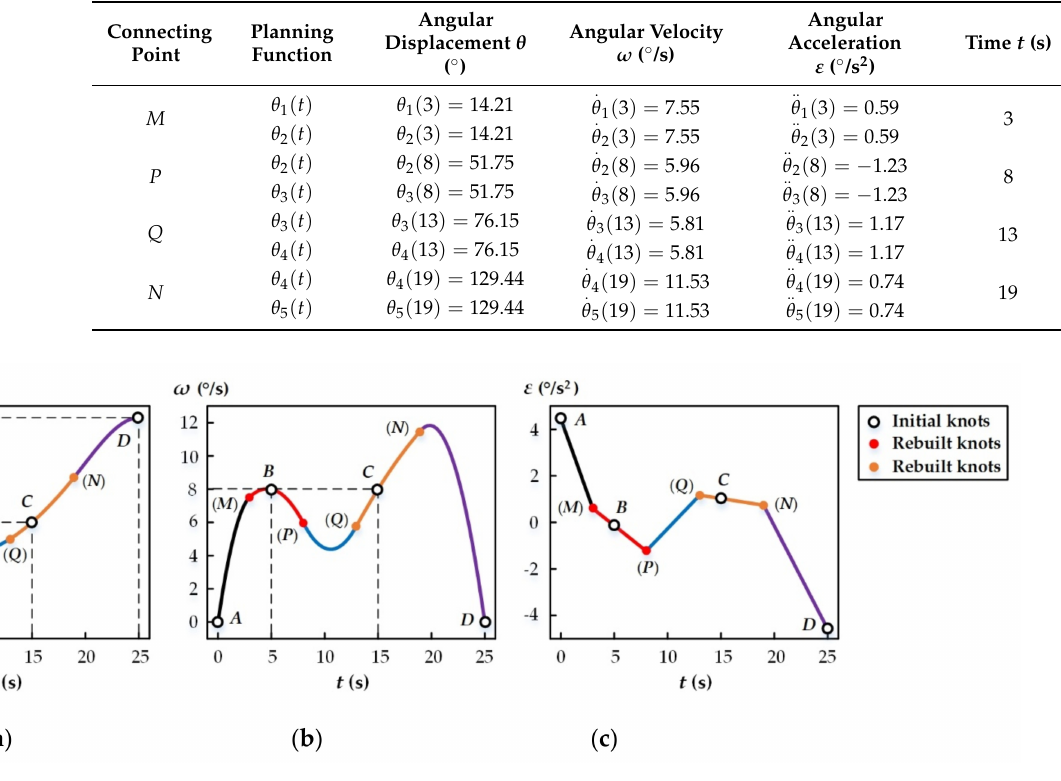
Figure 12. Motion planning curves by proposed method. ( a ) Angular displacement planning curves; ( b ) Angular velocity planning curves; ( c ) Angular acceleration planning